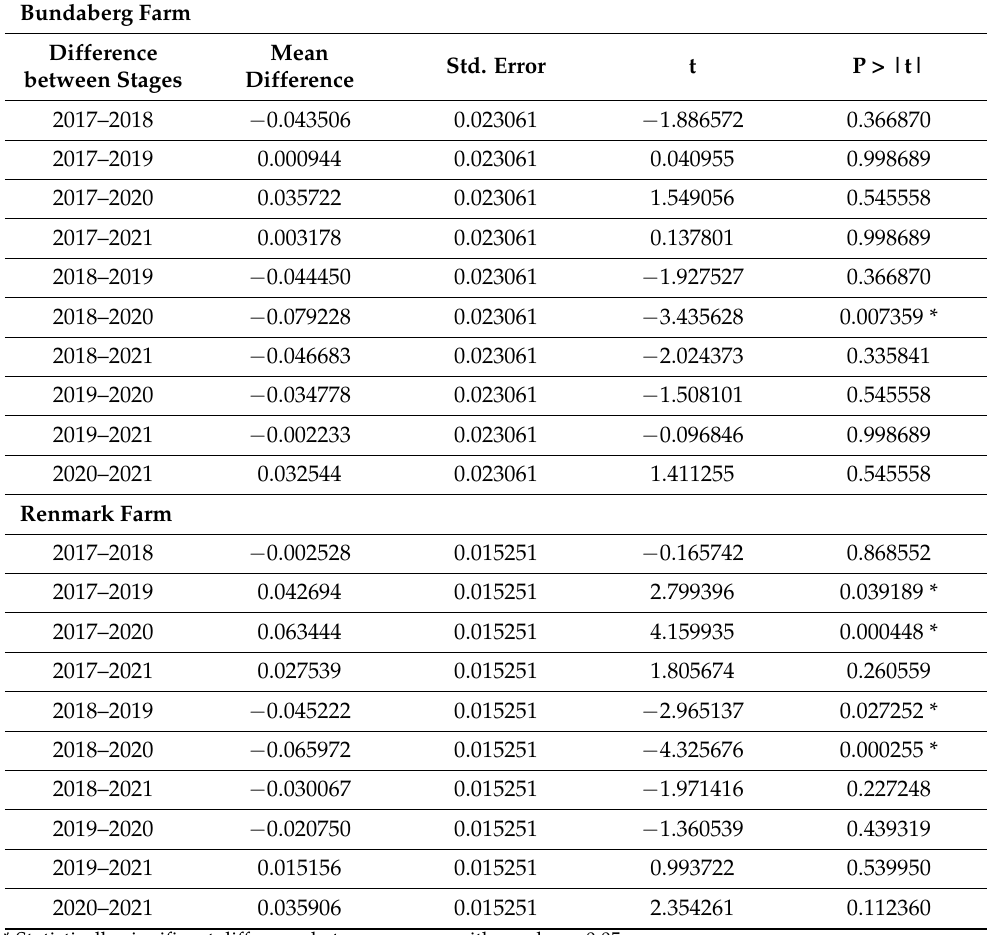
Table 3. Results of the Tukey-HSD test for the Bundaberg and Renmark avocado farms.